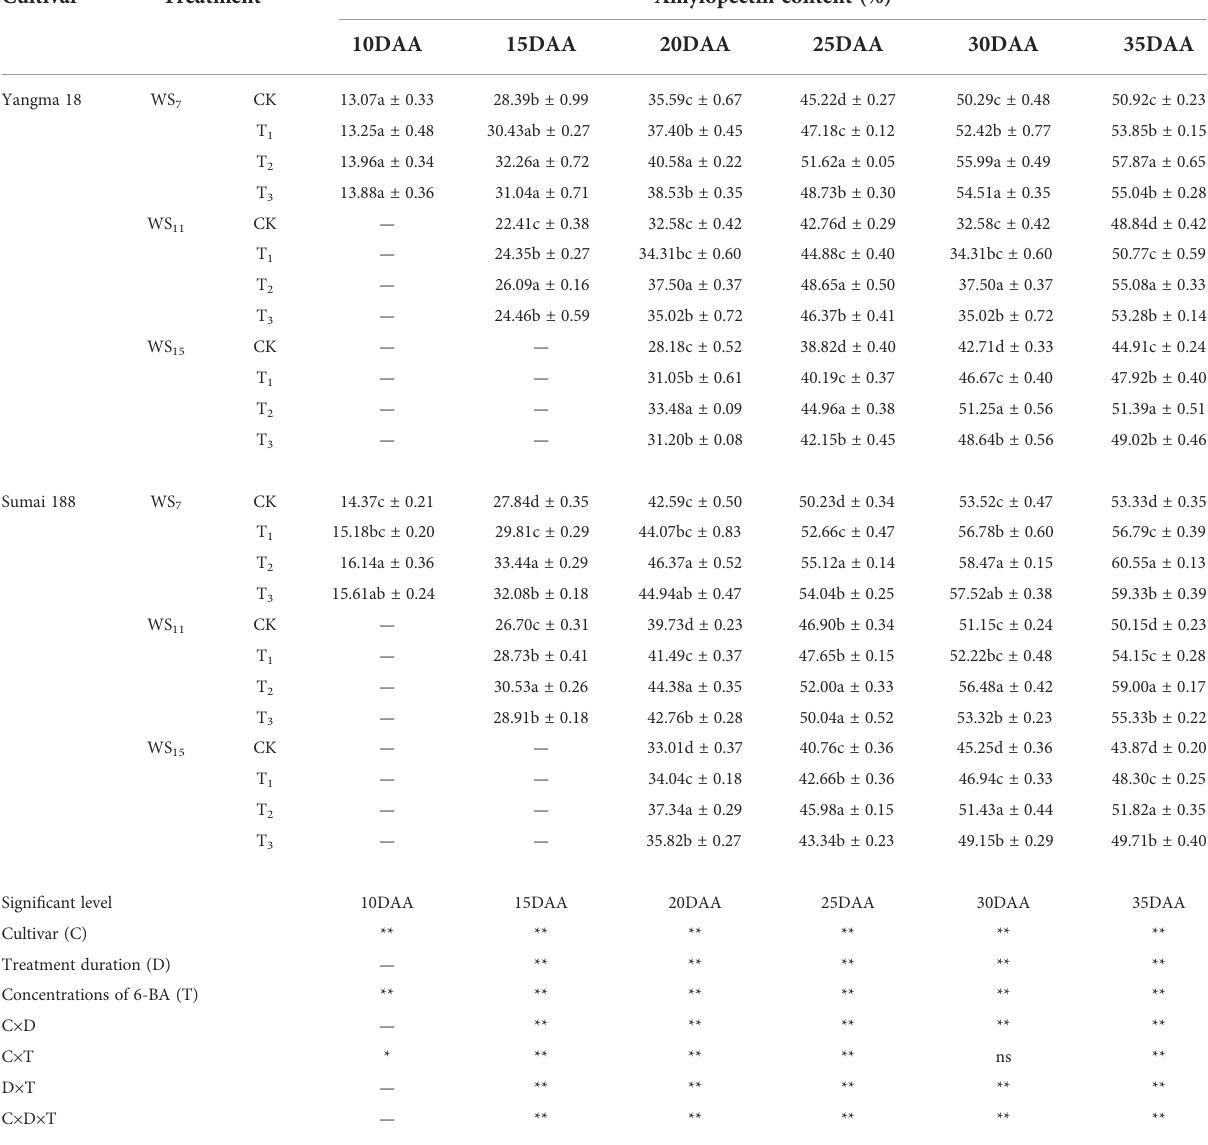
TABLE 3 The effect of exogenous 6-BA on amylopectin accumulation of wheat under waterlogging and shading in 2021. Cultivar